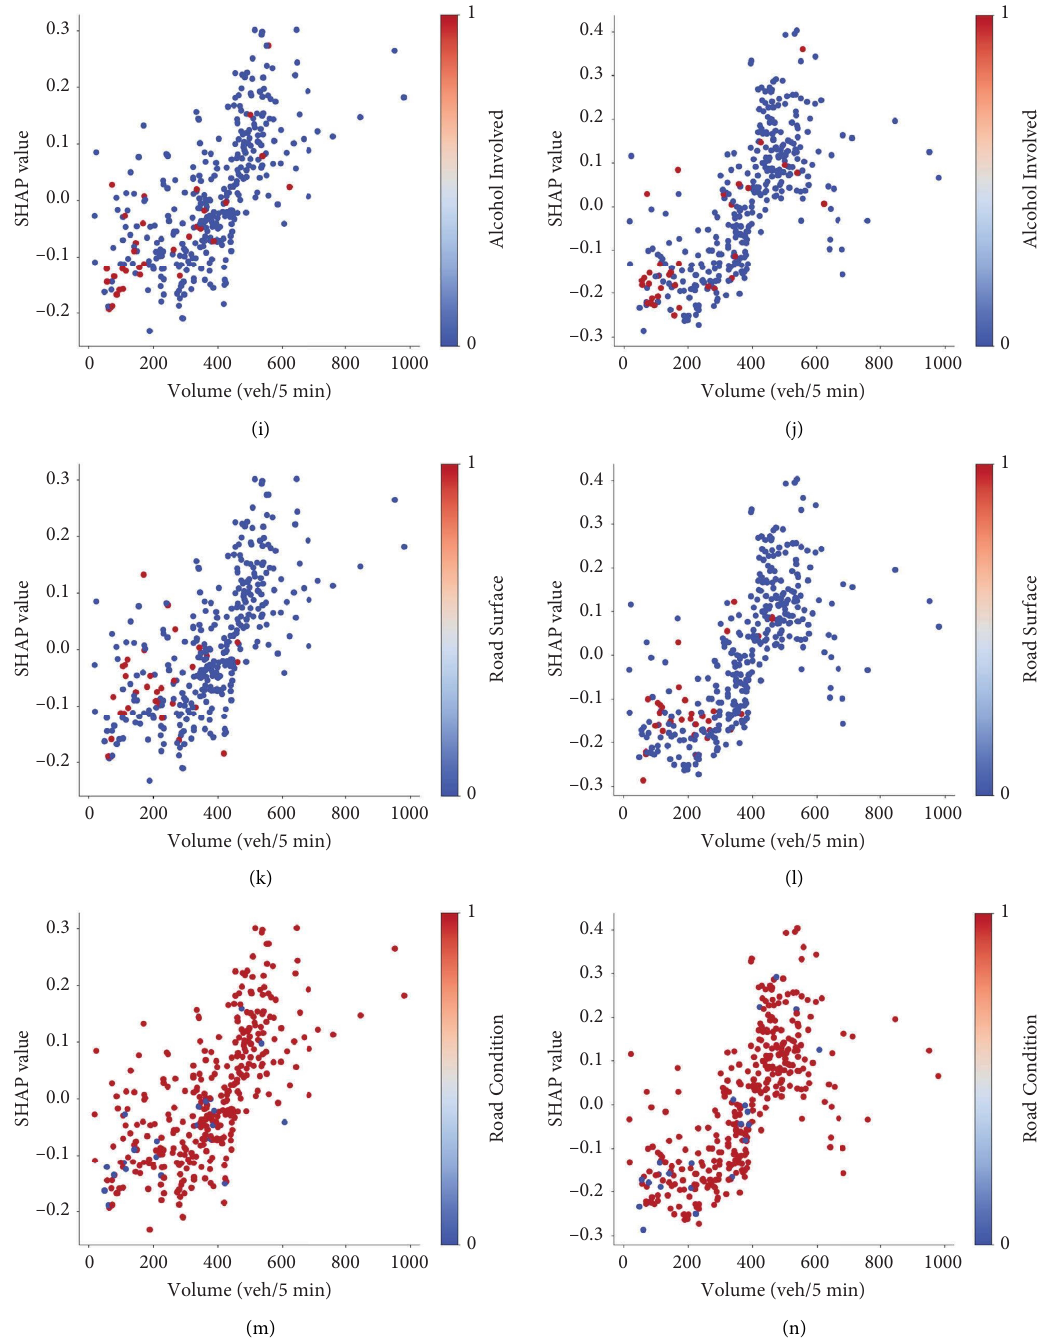
Figure 11: SHAP interaction efect plots among variables on the time gap and the distance gap. (a) Speed and weekend on the time gap. (b) Speed and weekend on the distance gap. (c) Collision type and volume on the time gap. (d) Collision type and volume on the distance gap. (e) Speed and collision type on the time gap. (f) Speed and collision type on the distance gap. (g) Volume and weather on the time gap. (h) Volume and weather on the distance gap. (i) Volume and alcohol involved on the time gap. (j) Volume and alcohol involved on the distance gap. (k) Volume and road surface on the time gap. (l) Volume and road surface on the distance gap. (m) Volume and road condition on the time gap. (n) Volume and road condition on the distance